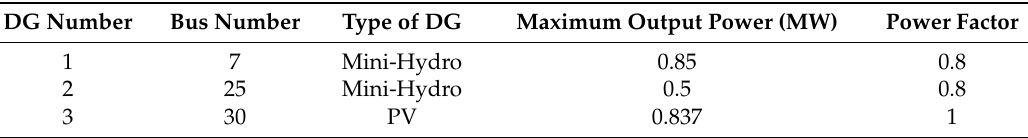
Figure 4. Test system. Table 1. Maximum active power produced by Distributed Generators (DGs).